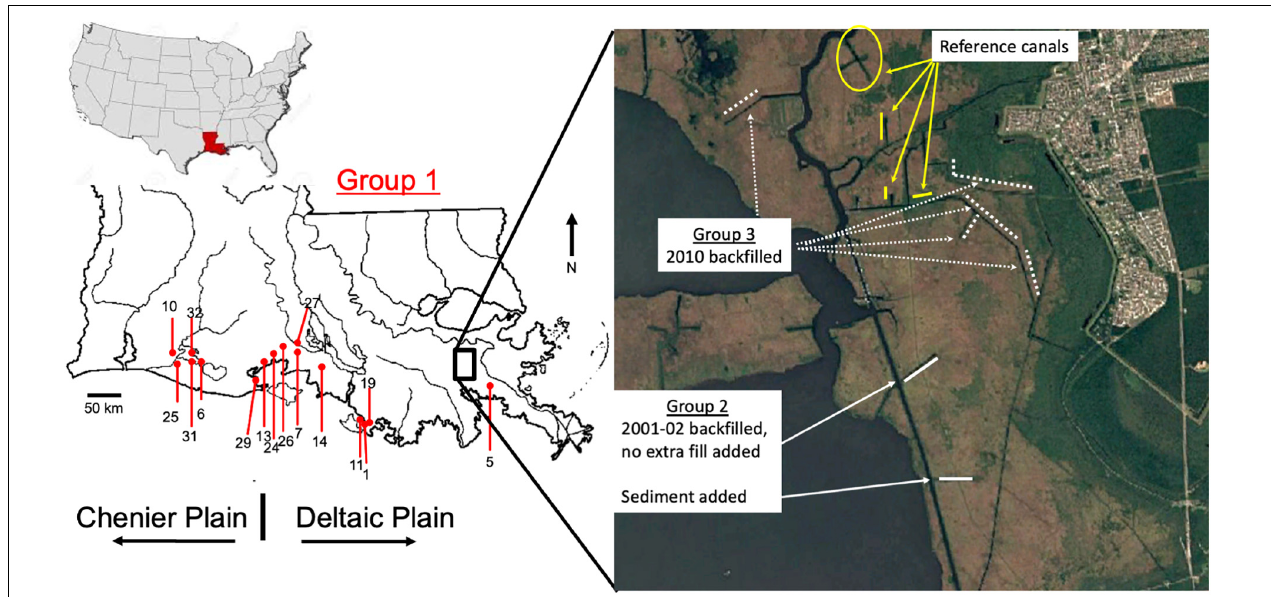
FIGURE 1 | Location of the sixteen across the Louisiana coast (Group 1) and the backfilled canals in the Jean Lafitte Park (Groups 2 and 3).